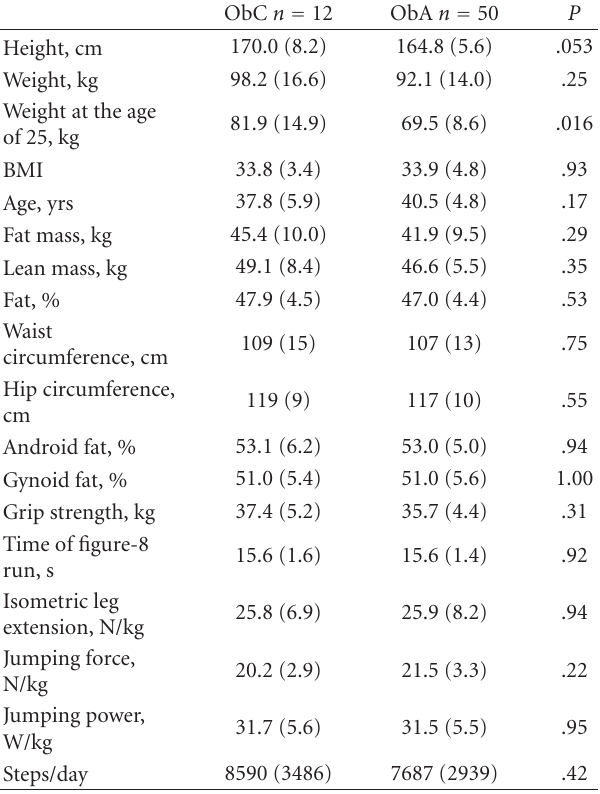
Table 1: Group characteristics (SD) among women who have been obese since childhood (ObC) and women who have become obese in